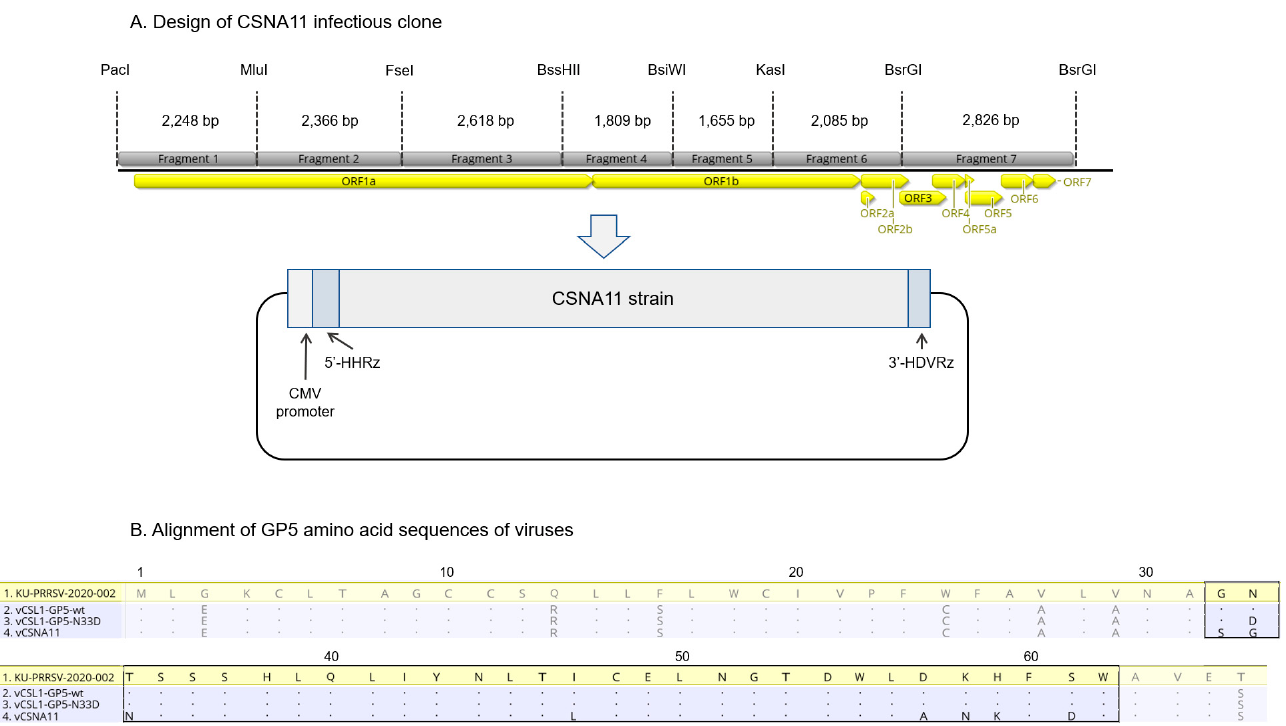
Figure 1. Design of CSNA11 infectious clone and alignment of glycoprotein (GP) 5 amino acid sequences of viruses. ( A ) Schematic diagram of CSNA11 infectious clone. The restriction enzyme sites used for assembling the infectious clone and the length of each fragment are indicated above the genomic construct. CMV: cytomegalovirus; HHRz: hammerhead ribozyme; HDVRz: hepatitis delta virus ribozyme. ( B ) Alignment of amino acid sequences of the GP5 N-terminal domain of viruses. Amino acids identical to those of the KU-PRRSV-2020-002 strain are represented as dots, and the ectodomain region (31 amino acids, 93 bp) is indicated by the black box.